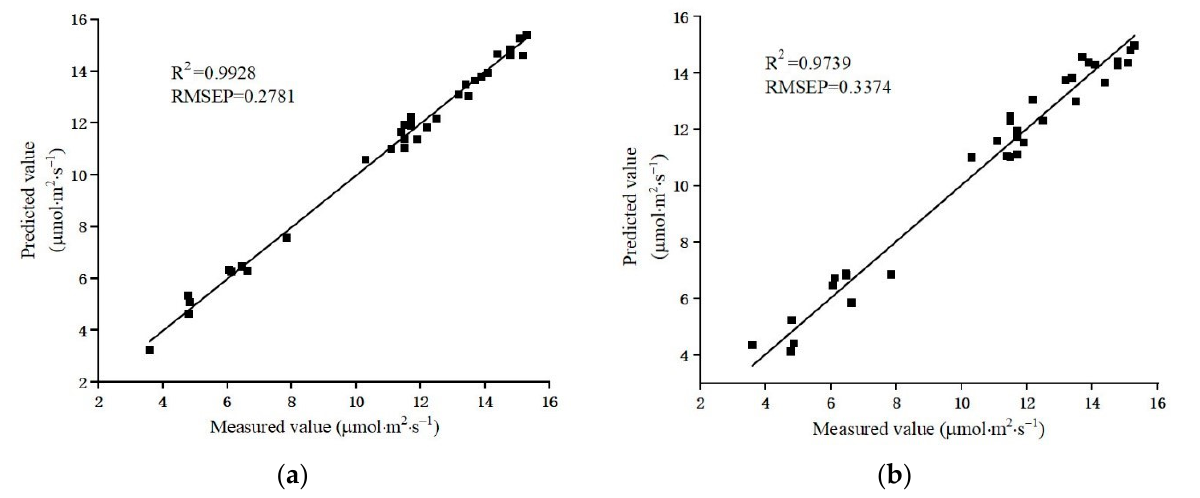
Figure 8. ( a ) Scatter plot of measured and predicted photosynthetic rates based on fluorescence spectral